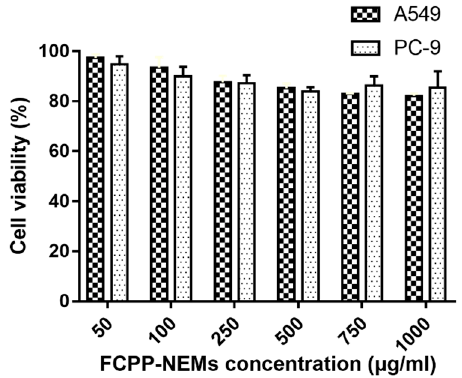
Figure 7. Effect of FCPP-NEMs on A549 and PC-9 cells at various concentrations ( n = 6).